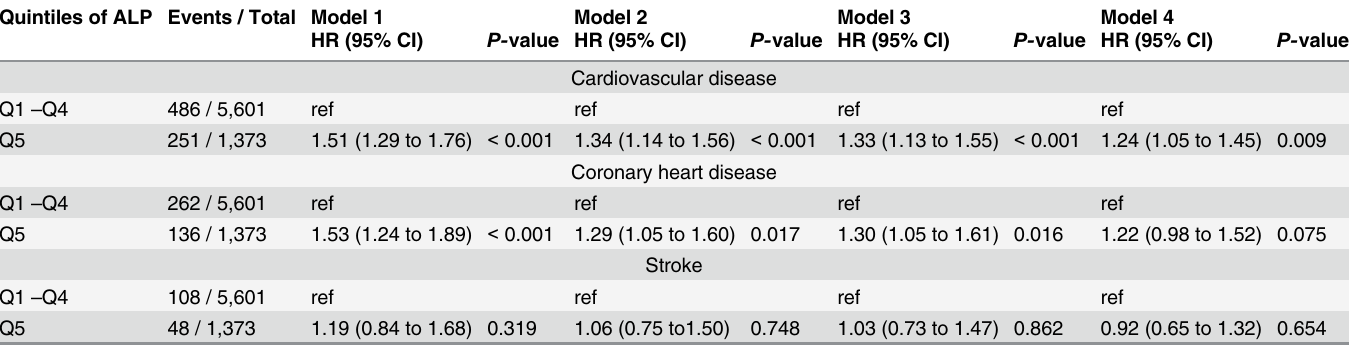
Table 2. Association of alkaline phosphatase with incident cardiovascular disease, coronary heart disease, and stroke. Quintiles of ALP Events / Total Model